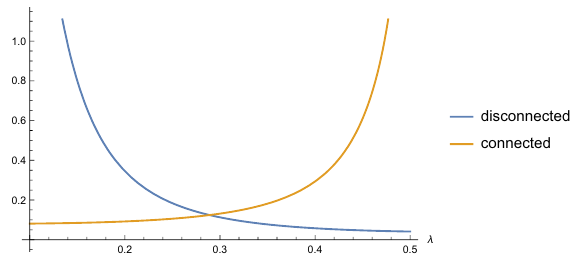
Figure 3 . Plot of the disconnected part h Z ( (cid:12) ) i 2 and the connected part h Z ( (cid:12) ) 2 i c as a function of (cid:21) = ~ (cid:12) at ~ = 1 =